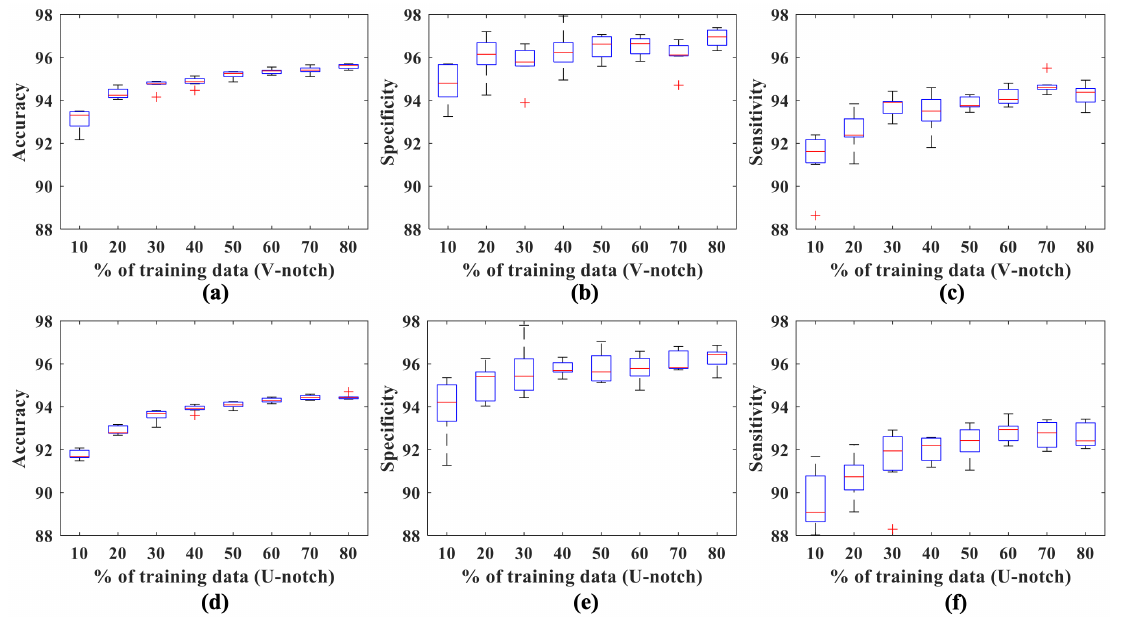
Figure 9. Effect of the training data volume when the baseline U-notch DNN is retrained with V-notch data to enable a prediction for V-notch: ( a ) accuracy, ( b ) specificity, and ( c ) sensitivity. Effect of the training data volume when the baseline V-notch DNN is retrained with U-notch data to enable a prediction for U-notch: ( d ) accuracy, ( e ) specificity, and ( f ) sensitivity. All the distributions indicate the variation for the corresponding training data across different retrained layers. For example: The box plot for 10% training data in ( a ) is a distribution of seven different accuracies corresponding to different number of re-trained